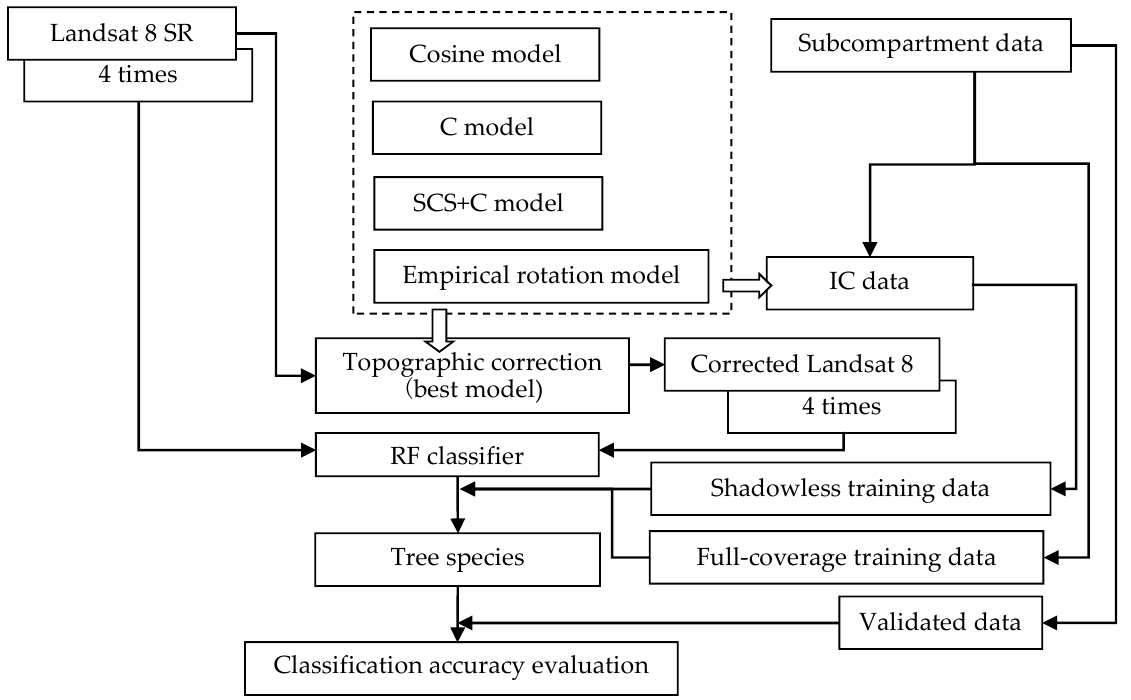
Figure 2. Methodological framework for the classification accuracy of topographic correction on tree species. IC: illumination conditions and RF: random forest.